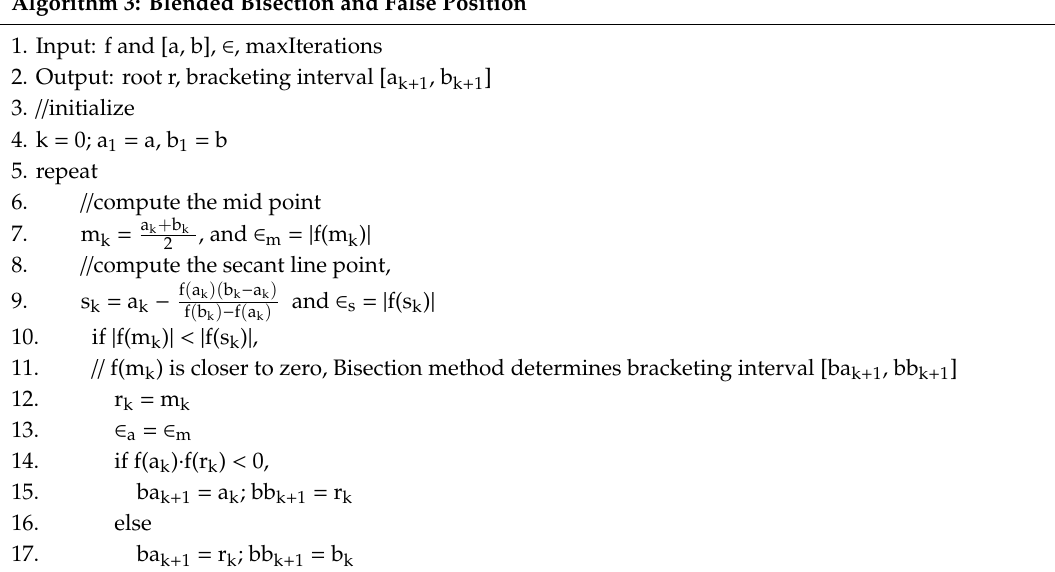
Algorithm 3: Blended Bisection and False